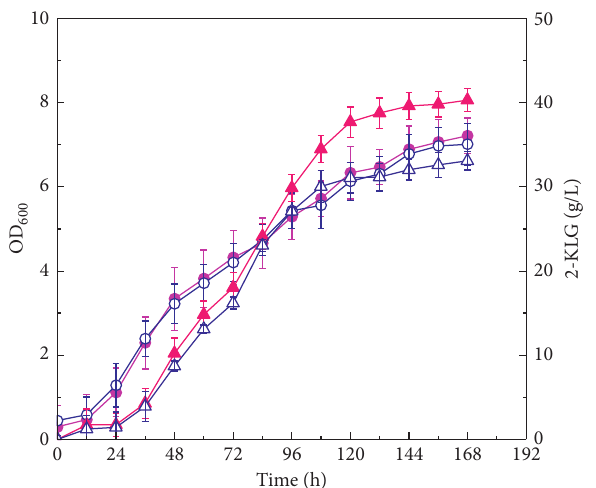
Figure 4: Time course of fermentation by CutA-based engineered strain. The symbols ▲ and △ represent the concentration of 2- KLG produced by G. oxydans /pGUC- tufB - SH3 - sdh -GGGGS- sndh - tufB - SH3 lig -(GGGGS) 2 - cutA and G. oxydans /pGUC- tufB - sdh -GGGGS- sndh , respectively. The symbols ● and ○ represent OD 600 of G. oxydans /pGUC- tufB - SH3 - sdh -GGGGS- sndh - tufB - SH3 lig -(GGGGS) 2 - cutA and G. oxydans /pGUC- tufB - sdh - GGGGS- sndh , respectively. Error bars represent the standard deviation of three biological replicates.